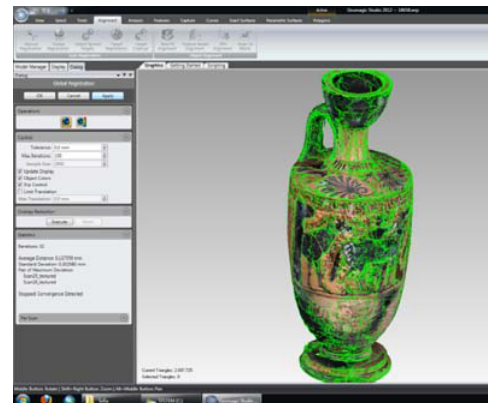
Fig. 5. The surface of a lekythos after the registration of all individual meshes